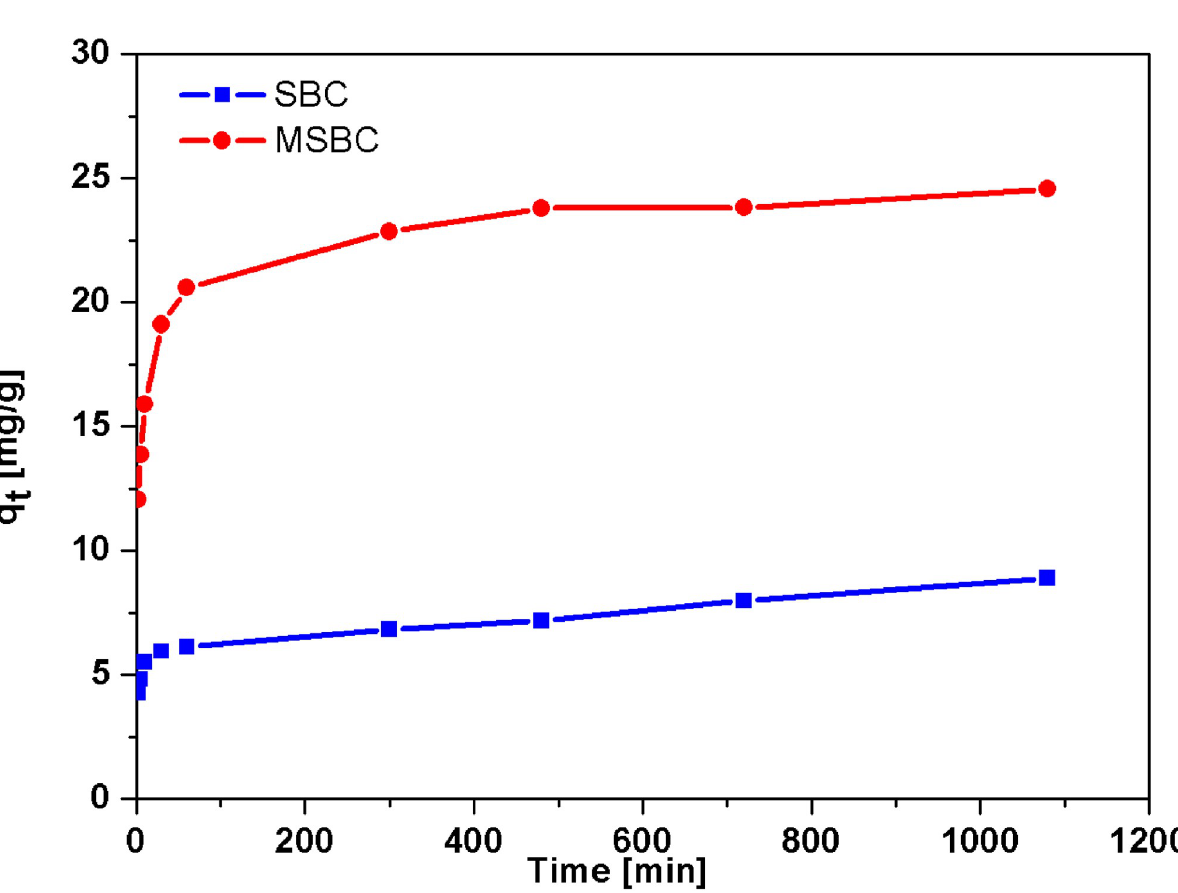
Fig 4. The kinetic of Ni(II) adsorption onto SBC and MSBC. Reaction conditions: Initial concentration of Ni(II) 100 ppm at pH 7, 50 ml of solution, 50 mg of MSBC, 18 h, 25 ˚C.